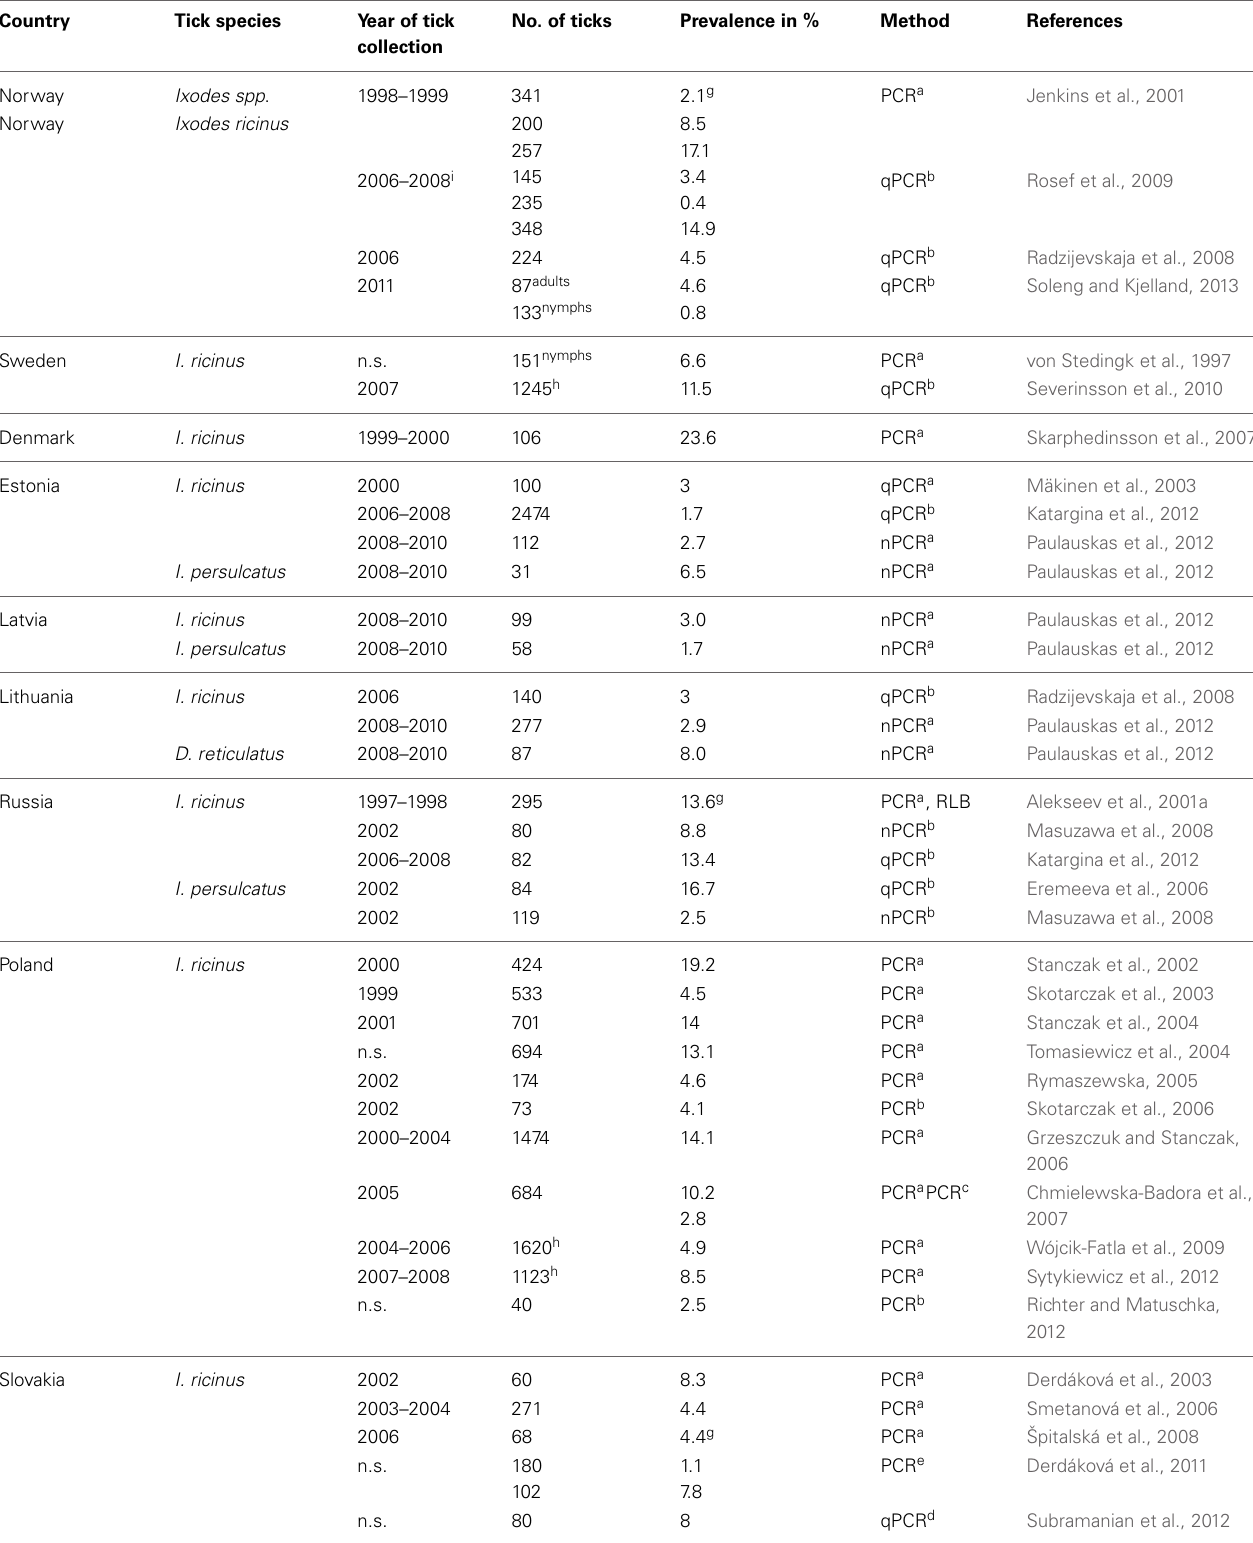
Table 3 | Molecular prevalence studies of Anaplasma phagocytophilum in questing ticks in Europe*.